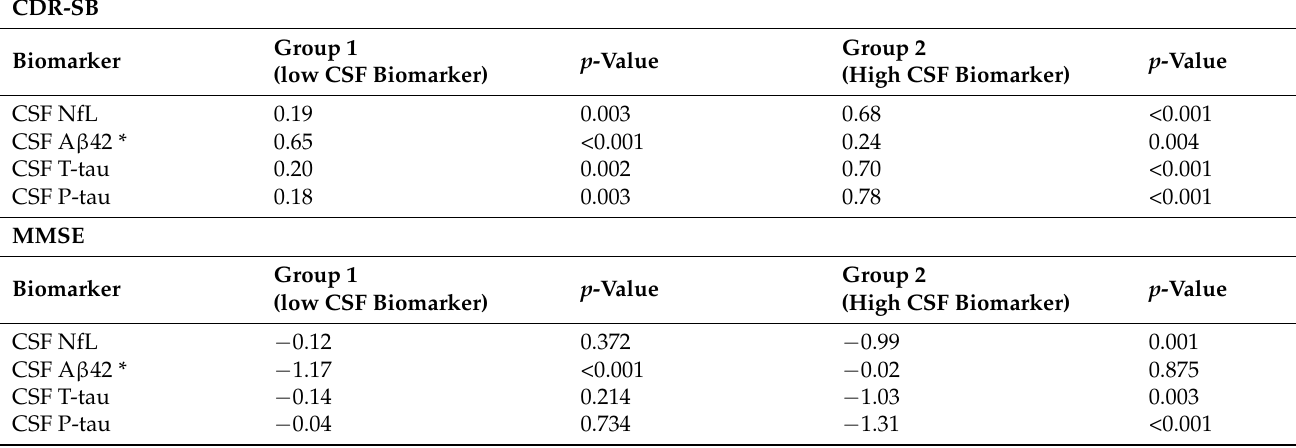
Table 3. Annual rate of change in MMSE and CDR-SB scores in participant groups with MCI–classified based on high and low measure of CSF